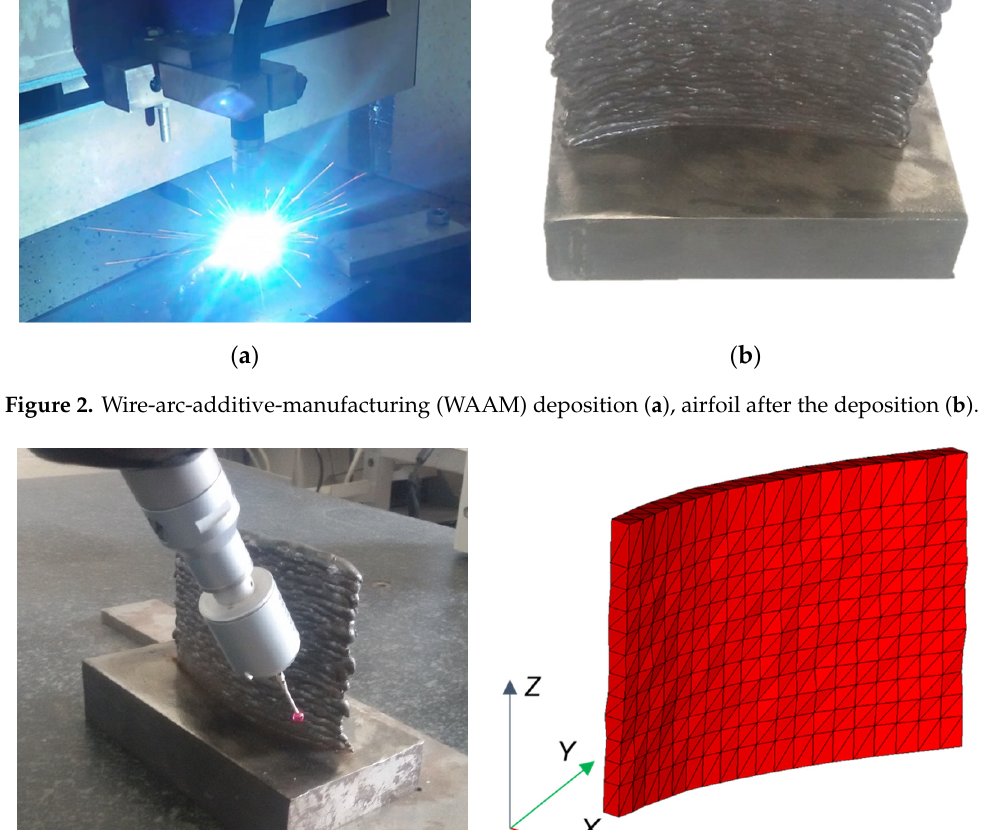
Figure 4. ( a ) Roughing cycle, ( b ) finished part.